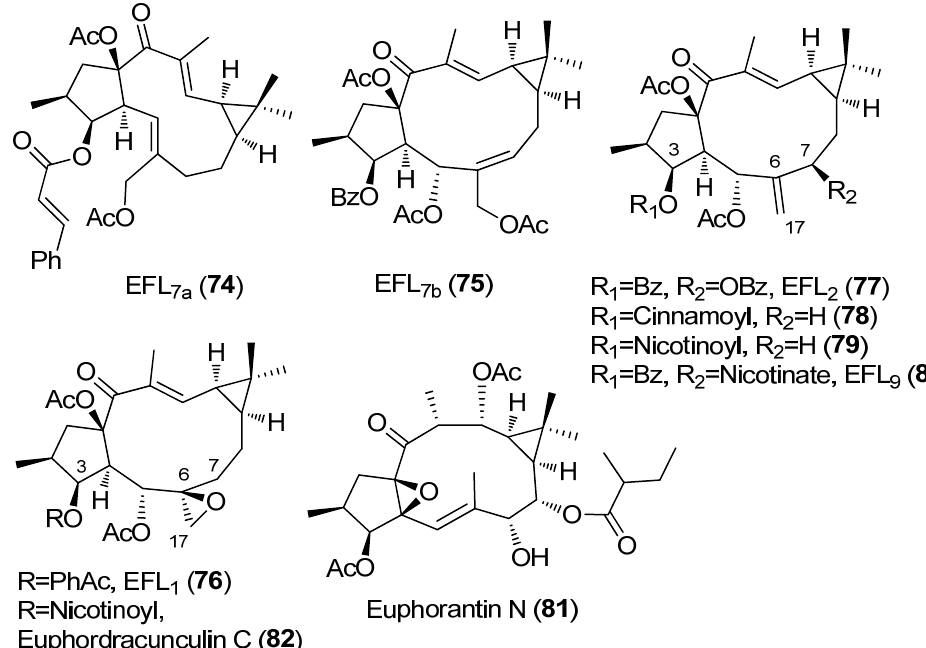
Figure 8. Chemical Structures of lathyranes from E. lathyris L with MDR-modulating activity (com- pounds 74 – 82 ). (compounds 74 – 82